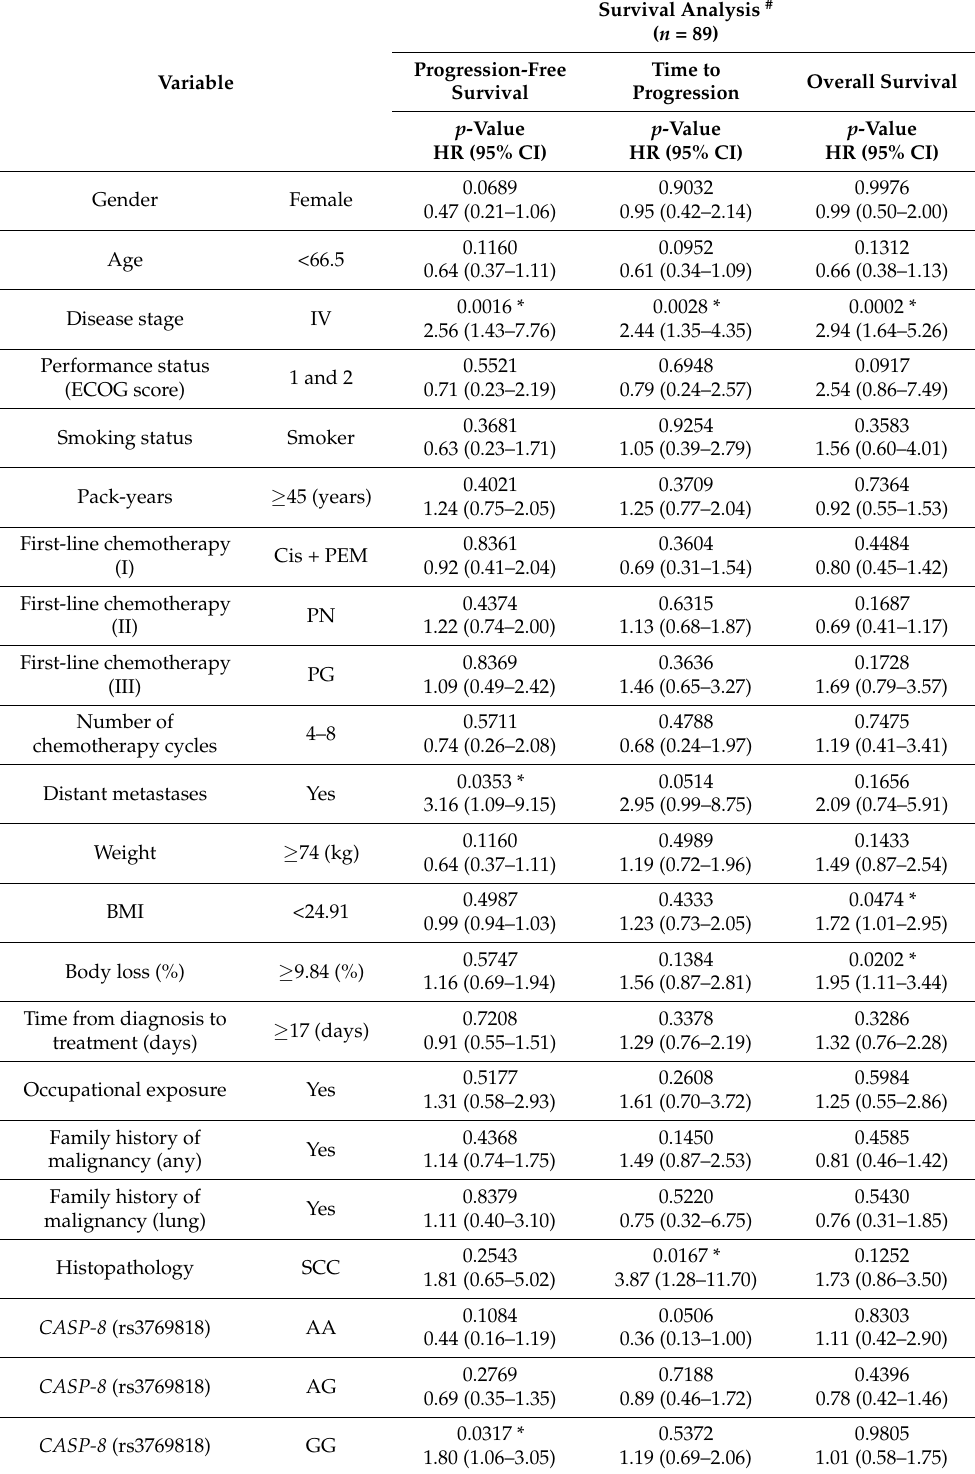
Table 6. Cox’s logistic regression analysis for progression-free survival, time to progression, and overall